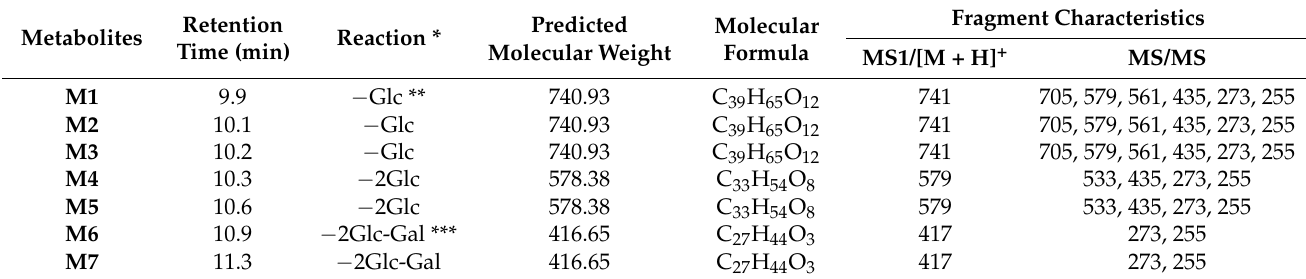
Table 1. Characteristics of Timosaponin BII metabolites in gut microbiota by LC/MS-Q-TOF.